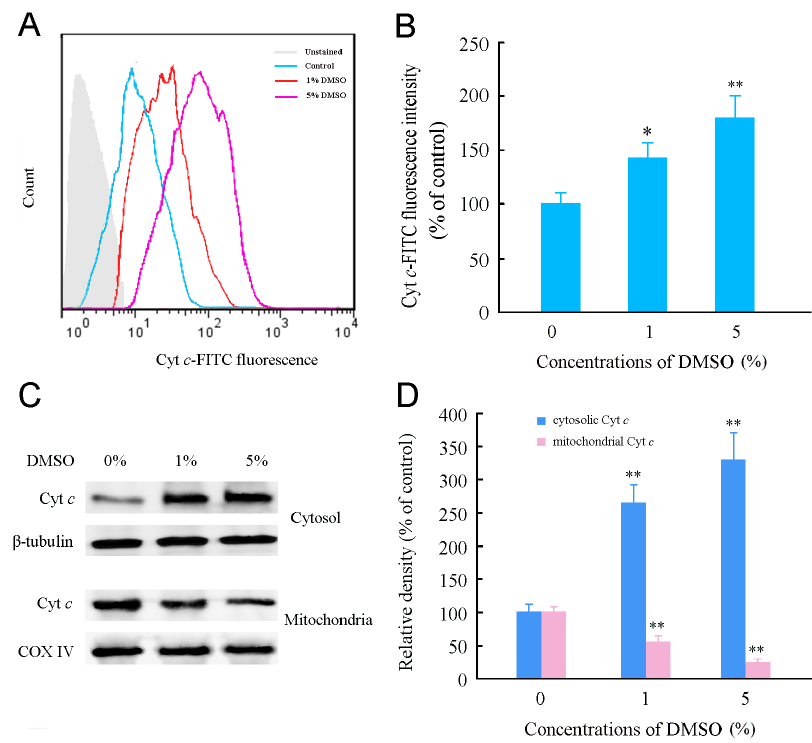
Figure 4. Effects of DMSO on and the release of mitochondrial Cyt c and intracellular ROS generation in cultured mouse cortical astrocytes. (A) Representative flow cytometry data showing mitochondrial Cyt c -FITC fluorescence within the cytoplasm of astrocytes treated with various concentrations of DMSO for 24 h. (B) Quantitative analysis of Cyt c -FITC fluorescence intensity. (C) Representative western blot bands showing expression levels of Cyt c in cytosolic and mitochondrial fractions of astrocytes treated with various concentrations of DMSO for 24 h. b -tubulin and COX IV, which were exclusively expressed within the cytosol and mitochondria, respectively, were used as loading controls. (D) The quantitative analysis of the relative optical density of cytosol and mitochondrial Cyt c showing that DMSO caused translocation of Cyt c from the mitochondria into the cytoplasm of astrocytes. Data are shown as a mean 6 SEM of five (for flow cytometry) or four (for Western blot) independent experiments performed in triplicate. * P , 0.05 and ** P , 0.01 versus control